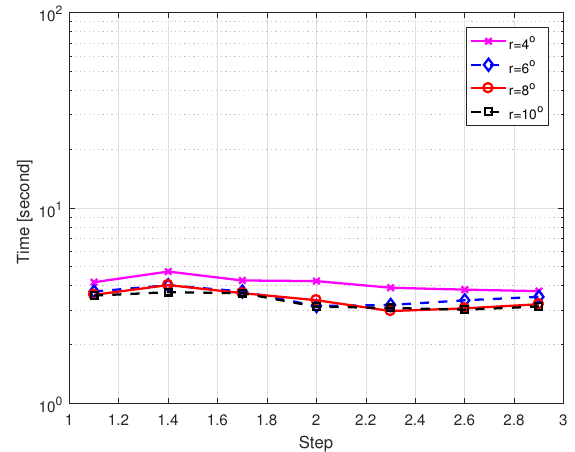
Figure 9. Computational time versus step with SNR = 10